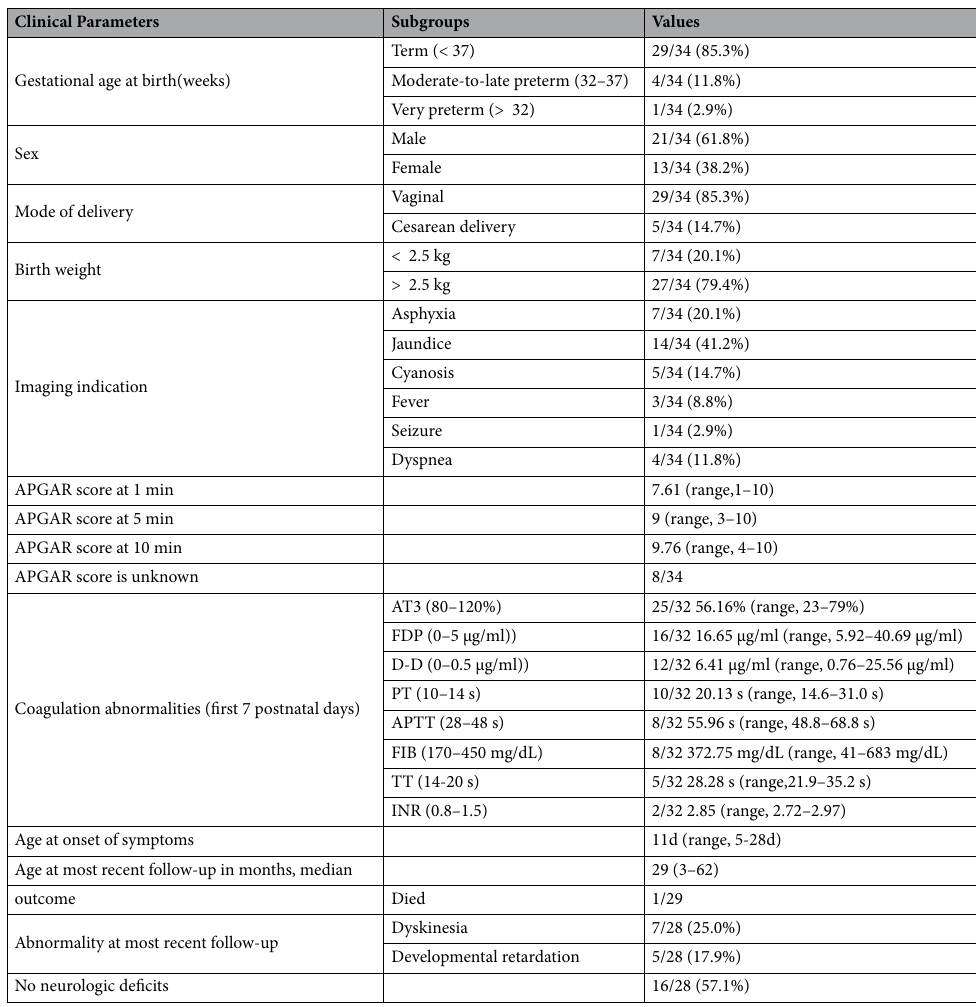
Table 1. Patient demographics, clinical presentation, and outcomes. AT3 antithrombin, APTT activated partial thromboplastin time, D-D D-Dimer, PT prothrombin time, INR international normalized ratio, FDP